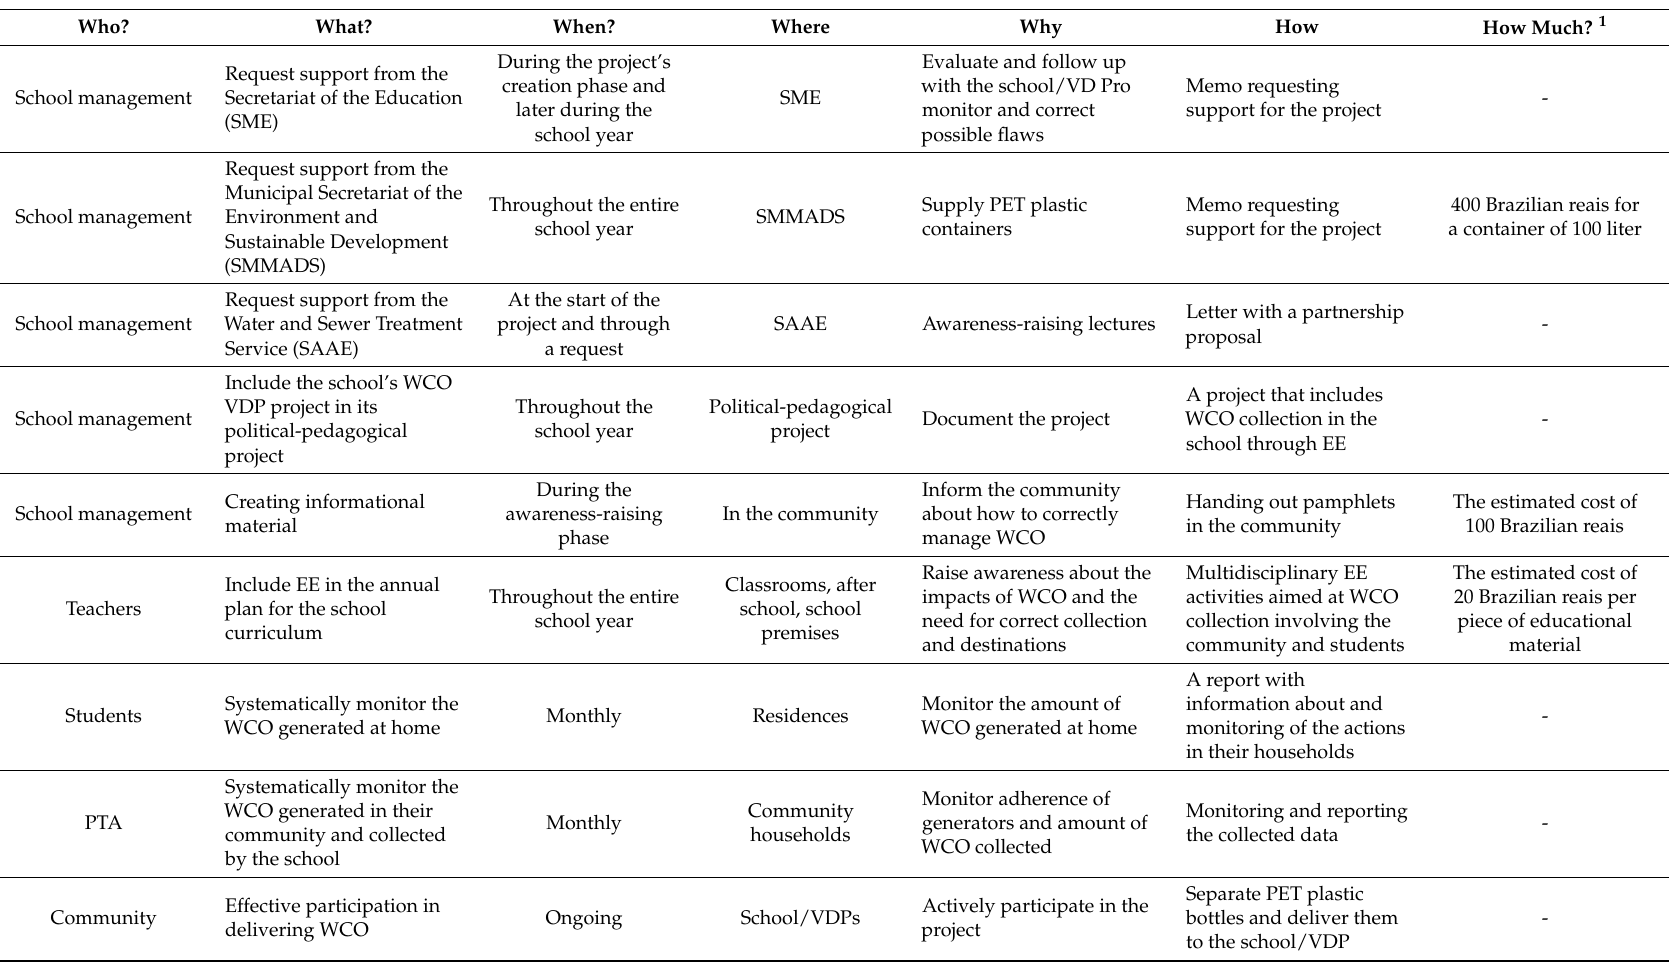
Table 4. An Action plan for inserting the Washington Luiz Municipal School in the WCO reverse supply chain. Source: Created by the